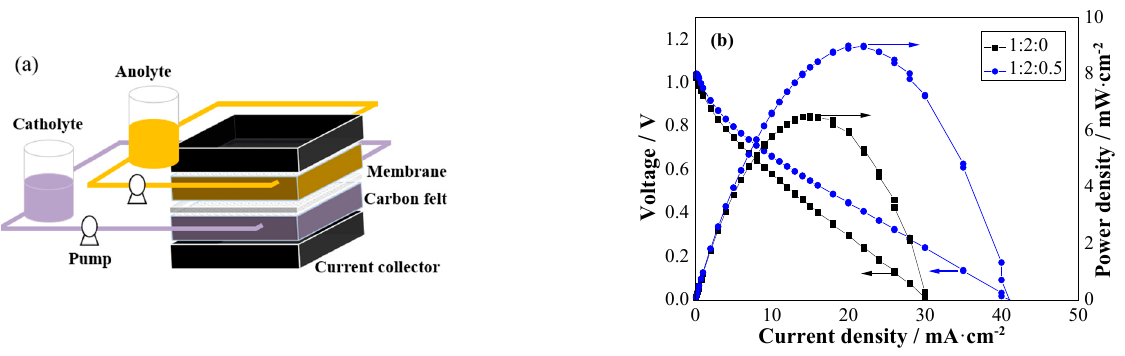
Figure 6. ( a )Assembly of ferrovanadium flow battery; ( b ) power density and I–V curves of ferrovanadium flow battery with the two different ratios of DESs.